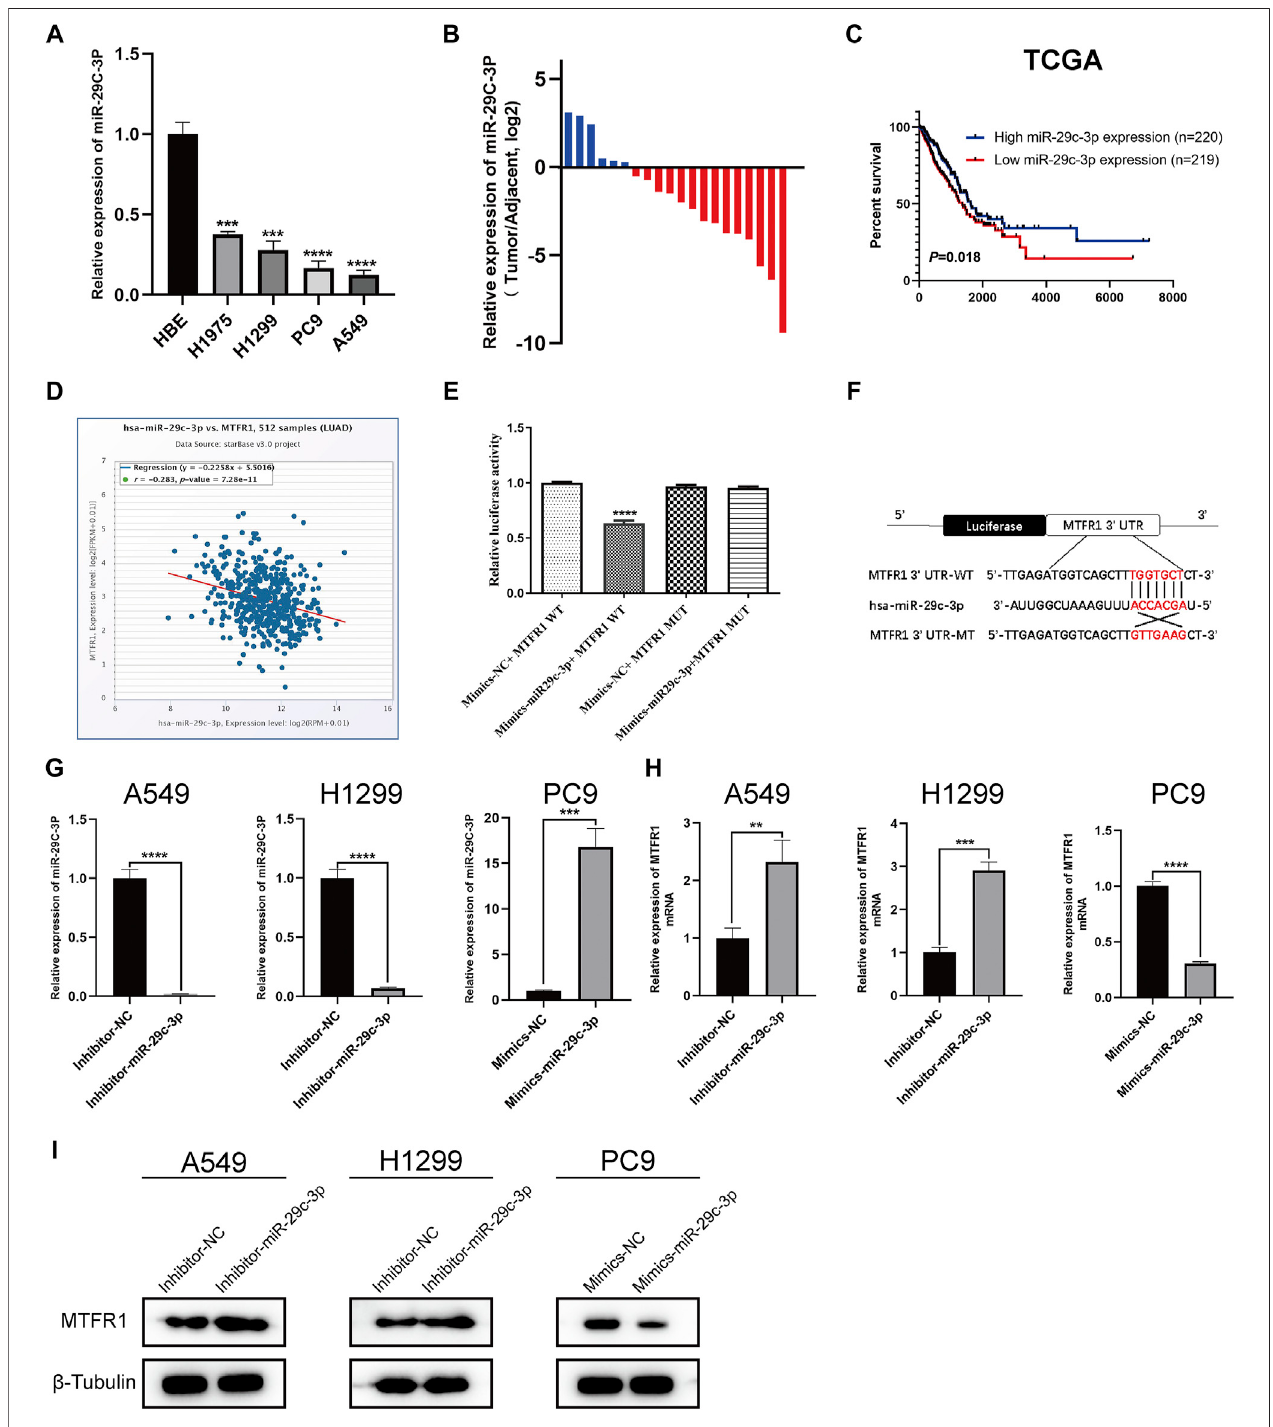
FIGURE 6 | MTFR1 is directly targeted by miR-29c-3p. (A) miR-29c-3p expression in different cell lines. (B) The relative expression of miR-29c-3p in 20 pairs of LUAD tissues and their corresponding adjoining paracancerous tissues. (C) Kaplan – Meier analysis of TCGA LUAD samples based on miR-29c-3p expression. (D) Pearson ’ s correlation analysis for assessing the relationship between miR-29c-3p and MTFR1 expression. (E, F) Results of the dual-luciferase reporter assay and the predictedbindingsitebetweenmiR-29c-3pand MTFR13 ′ -UTR. (G – I) TheexpressionofmiR-29c-3p andMTFR1incellstransfectedwithinhibitor-miR-29c-3p or mimic-miR-29c-3p. Data were articulated as the mean ± standard deviation (SD; ** p < 0.01, *** p < 0.001, **** p < 0.0001).